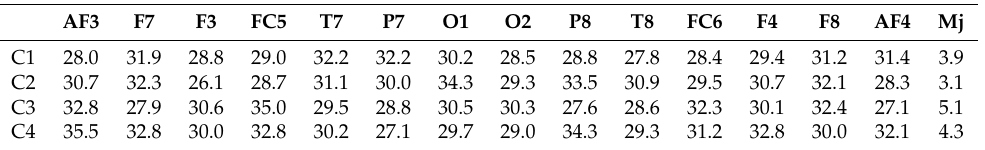
Table 6. EERs (%) in four conditions.